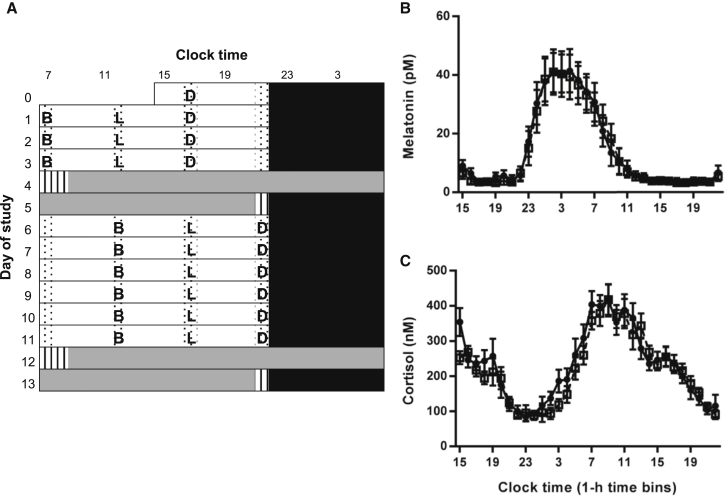
Study Protocol and Phase of SCN-Driven Hormone Rhythms(A) In order to maximize circadian entrainment prior to beginning the study protocol, participants maintained a self-selected pre-laboratory light-dark and sleep-wake pattern based on their habitual routine for 10 days. During the last week of the pre-laboratory period they ate breakfast (B) 30 min after wake, lunch (L) 5.5 hr after wake, and dinner (D) 10.5 hr after wake. Participants then entered the laboratory on day 0. During days 0–3, participants remained on their self-selected sleep-wake cycle. They slept in individual bedrooms in darkness (0 lux; black bars) and were awake in bright room light (∼500 lux in direction of gaze) during the day. Waking time was spent in communal areas (white bars) and in individual rooms (dotted bars). Isocaloric meals (B, L, D) were given 0.5, 5.5, and 10.5 hr after waking up, matching the week of pre-laboratory meal timing. On day 4, participants began a 37-hr constant routine in individual rooms (<8 lux; gray bars). Participants had a standard night’s sleep on day 5, before 6 more days of the sleep-wake and light-dark cycles (days 6–11). Conditions were equal to days 1–3 except for a 5-hr delay in all meal times. A second constant routine then commenced on day 12. Immediately before and after each constant routine, participants were kept in a constant routine-like environment but allowed to move within their rooms (hatched bars).(B and C) Concentration of melatonin (B) and cortisol (C) in hourly plasma samples collected in constant routine conditions. Black circles with solid lines represent data following early meals (0.5, 5.5, and 10.5 hr after waking up). White squares with dashed lines represent data following a 5-hr delay in each meal. Two-way repeated-measures ANOVA revealed a significant effect of time (melatonin: F(31, 279) = 19.00, p < 0.001; cortisol: F(31, 279) = 20.31, p < 0.001), but no significant effect of meals (melatonin: F(1, 9) = 2.97, p = 0.119; cortisol: F(1, 9) = 2.27, p = 0.166) or meal × time interaction (melatonin: F(31, 279) = 0.13, p = 0.124; cortisol: F(31, 279) = 1.39, p = 0.090). Data are mean ± SEM, n = 10. Statistical significance is defined as p < 0.01 (following Bonferroni correction for analysis of a total of five rhythmic plasma markers).See also Figures S1 and S2.